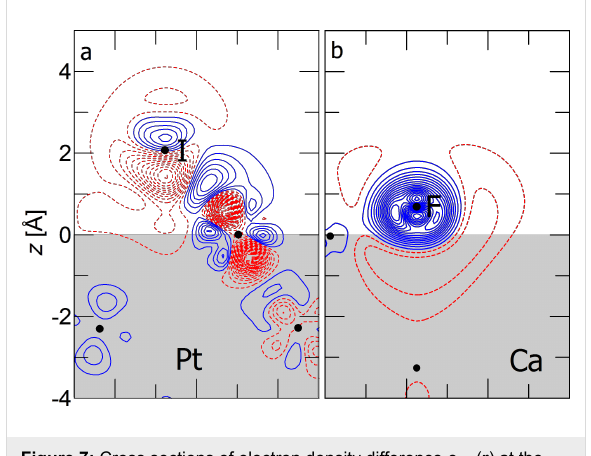
Figure 7: Cross sections of electron density difference ρ diff ( r ) at the surface. Solid-blue (dashed-red) contours denote regions of electron buildup (depletion). The interval between contours of constant elec- tron density is 0.01 electrons/Å 3 . The region of the metal slab is shaded gray as a visual